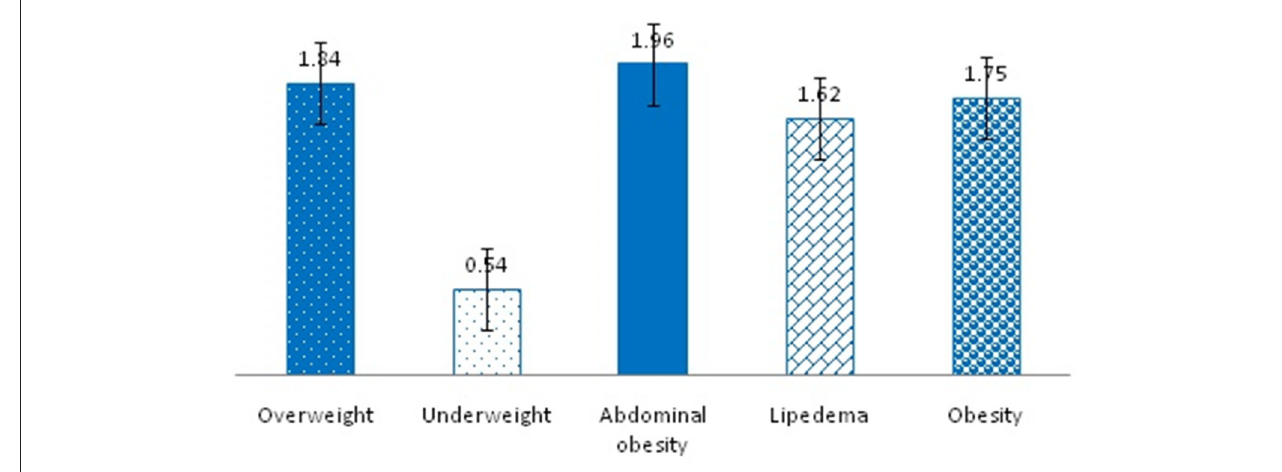
FIGURE 2 | Self-perceived in the bodyweight status.